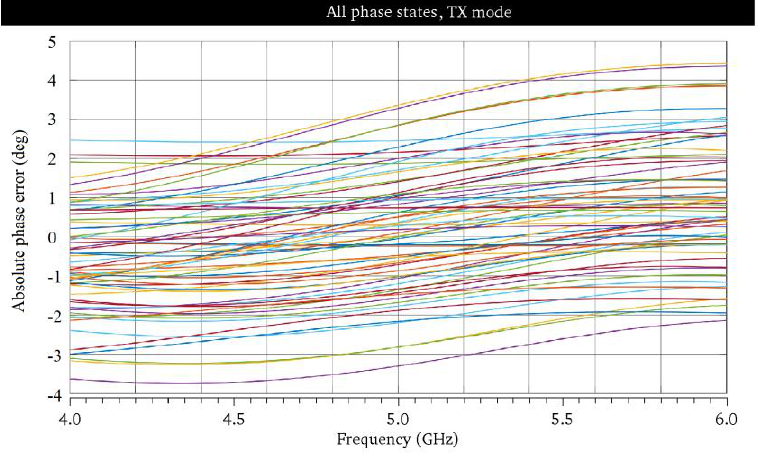
Fig. 5. Frequency dependence of the relative phase shifts from the control code in Tx mode.